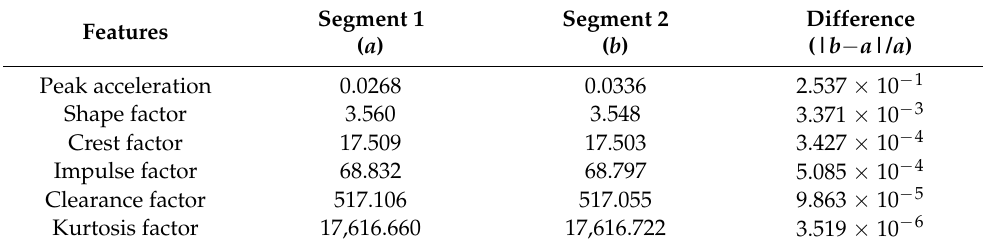
Table 2. Six features of the two segments and their relative differences in the early stage of monitoring.